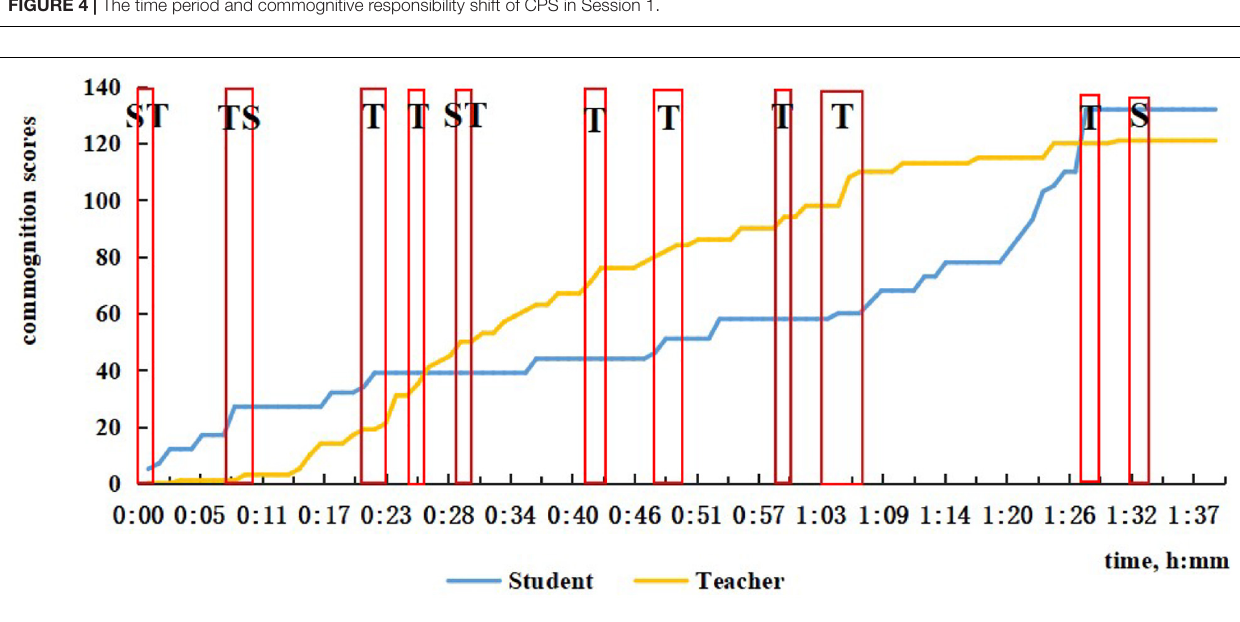
FIGURE 4 | The time period and commognitive responsibility shift of CPS in Session 1.